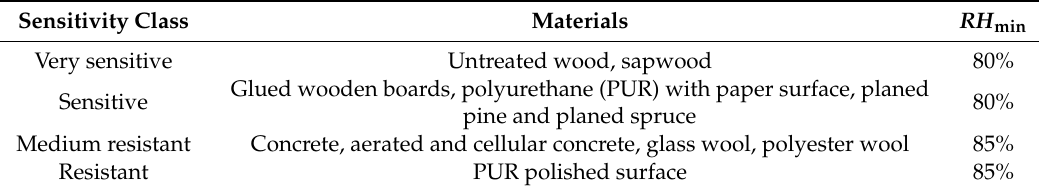
Table 3. Mold growth sensitivity classes, some corresponding materials and RH min values [45].